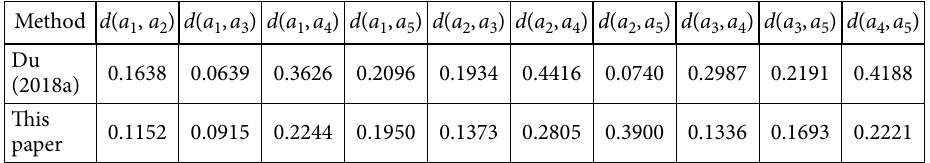
Table 1. Calculation results of the Euclidean distances between q-ROFNs